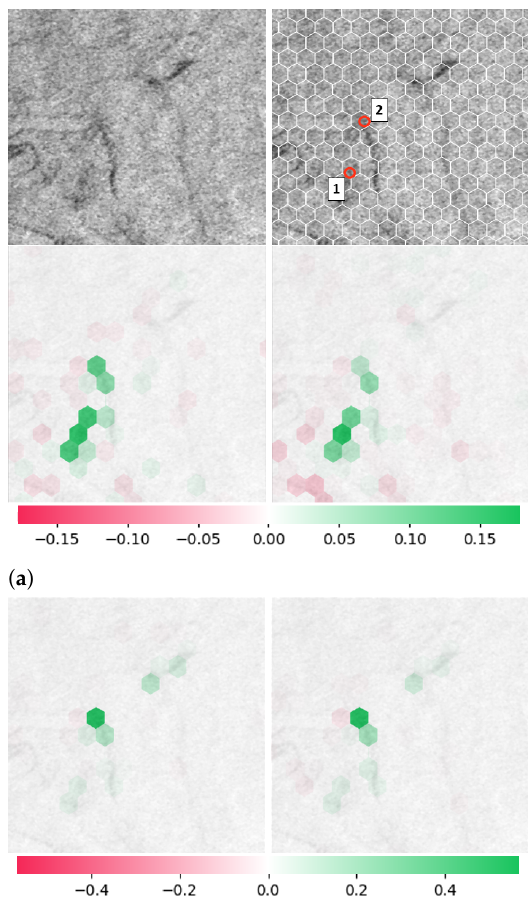
Figure 24. Results of SHAP explanation function, showing the difference between both studied experiments. ( a ) SHAP images for pixel number 1, classified as a slick by T SAR model and as sea by T 1 ; ( b ) SHAP images for pixel number 2, classified as slick. Same legend as Figure